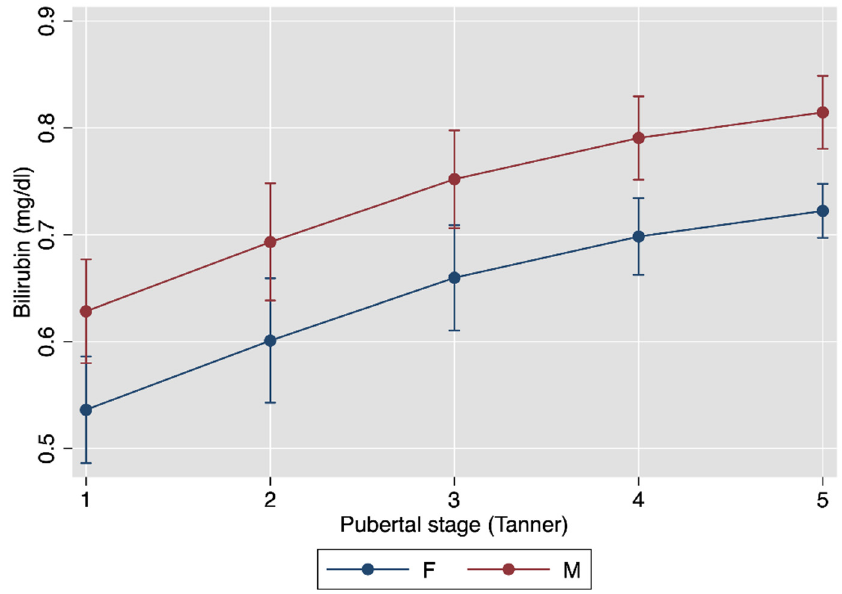
Figure 2. Association between bilirubin and pubertal status. See Table 2 for the underlying linear regression model. Table 2 . Multivariable linear regression models evaluating the association between serum total bilirubin and age and pubertal status.